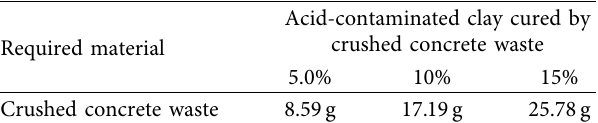
Table 5: Mass of crushed concrete waste required for preparing acid-contaminated clay cured by crushed concrete waste of dif- ferent contents.